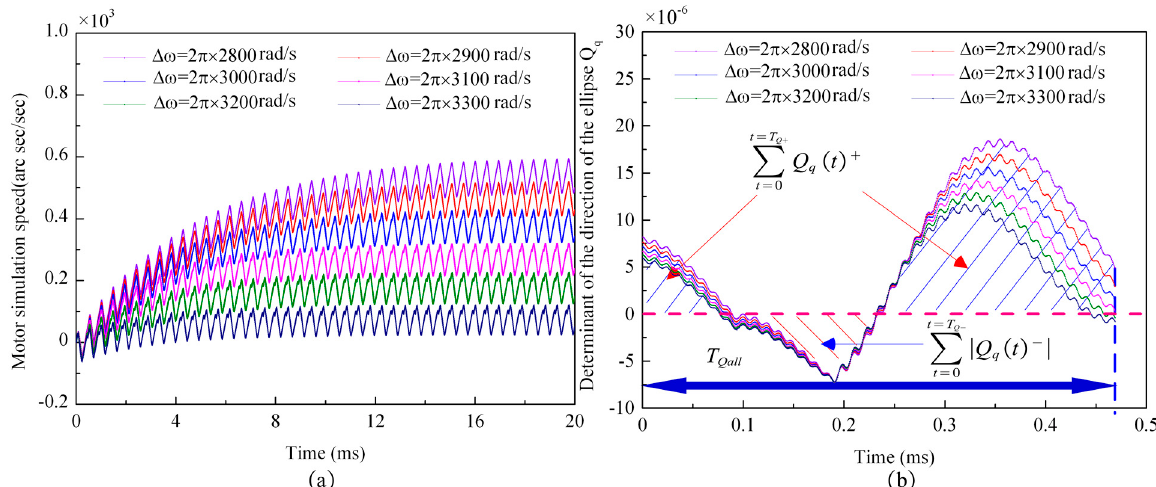
Figure 20. The simulation curve for the determining factors of motor instantaneous speed and elliptical direction of motion with frequency difference: ( a ) simulation curve of motor instantaneous speed; and ( b ) simulation curve of determining factors for the elliptical direction of motion within one cycle of the superimposed pulse driving method.